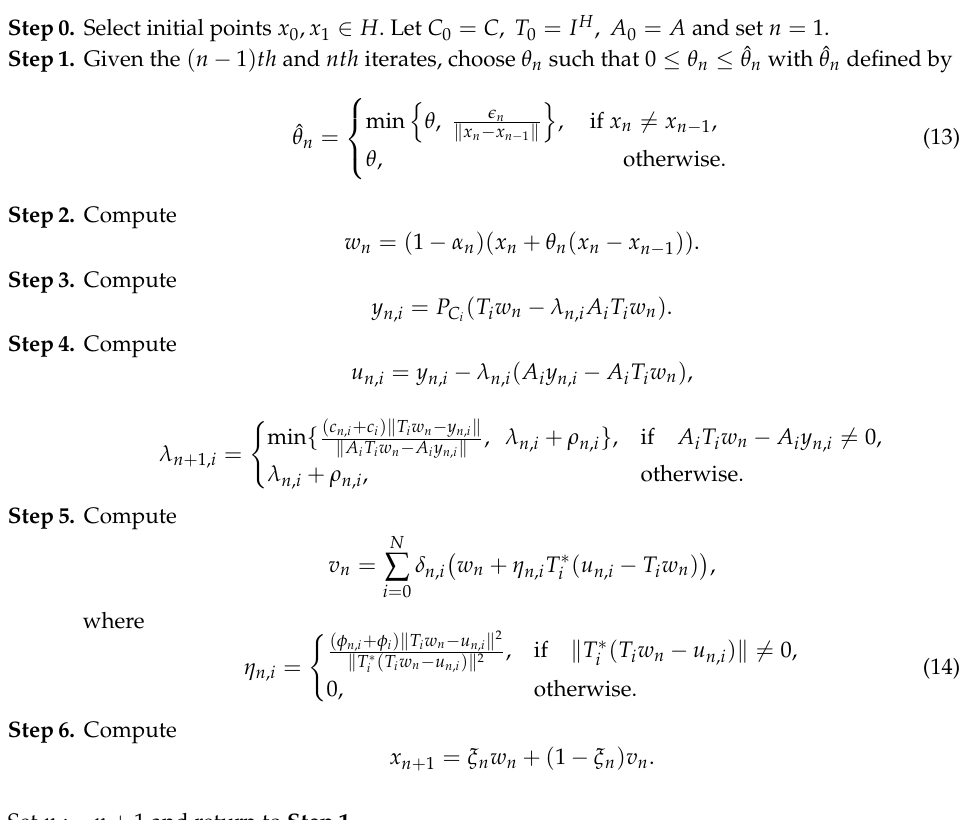
Algorithm 1. A Relaxed Inertial Tseng’s Extragradient Method for Solving SVIPMOS